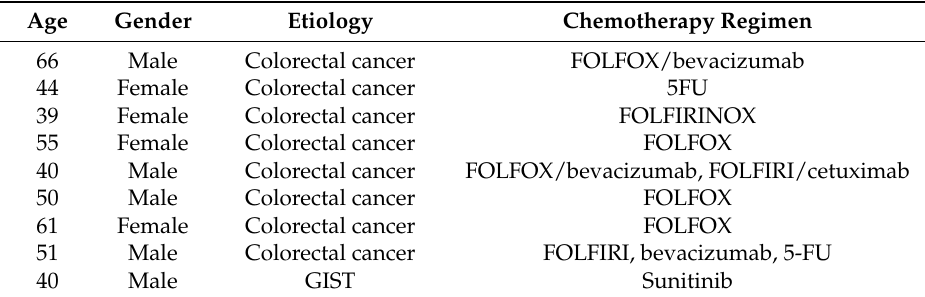
Table 2. Systemic therapy administered to patients after PVE before surgical